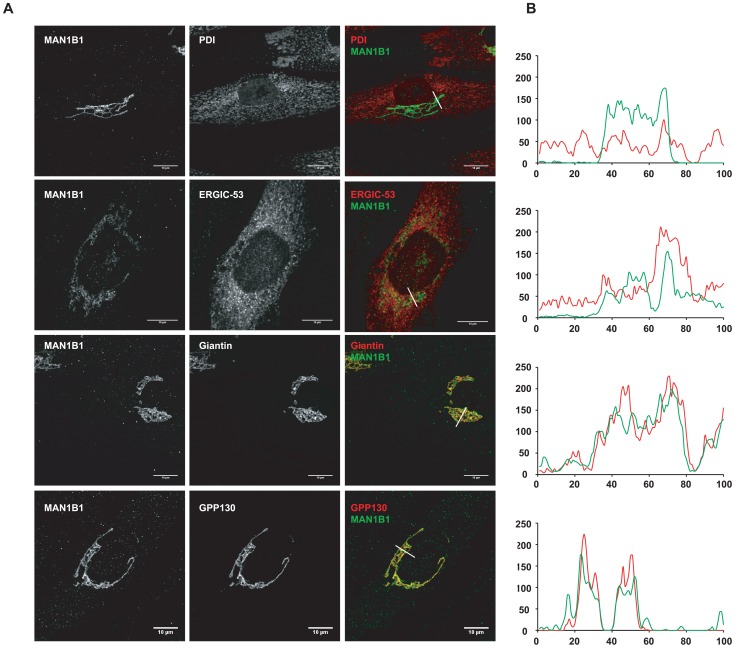
Subcellular localisation of MAN1B1.(A) Indirect double immunofluorescence staining of control and MAN1B1-deficient fibroblasts. The cells were double-labelled with antibodies against MAN1B1 and with antibodies against either the Golgi markers GPP130 and giantin, the ER-Golgi intermediate compartment (ERGIC) marker ERGIC-53, or the ER marker PDI. The cells were then examined by confocal laser scanning microscopy. Images were collected under identical settings. Scale bar represents 10 µm. (B) Confocal linescan analysis of the distribution of MAN1B1. The pixel intensity (vertical axis) of MAN1B1 (green) and PDI, ERGIC-53, giantin and GPP130 (from top to bottom, red) was hence measured along a vector drawn perpendicular across the Golgi stack and plotted versus distance (horizontal axis), using the RGB profiler plugin from Image J.